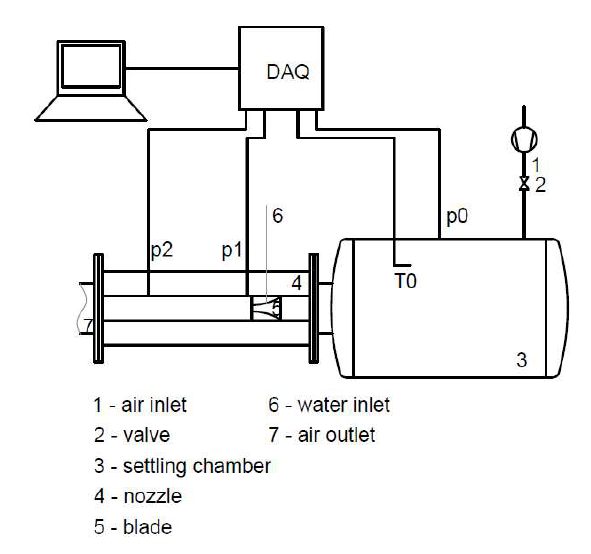
Fig. 2. The wind tunnel measurement schema .